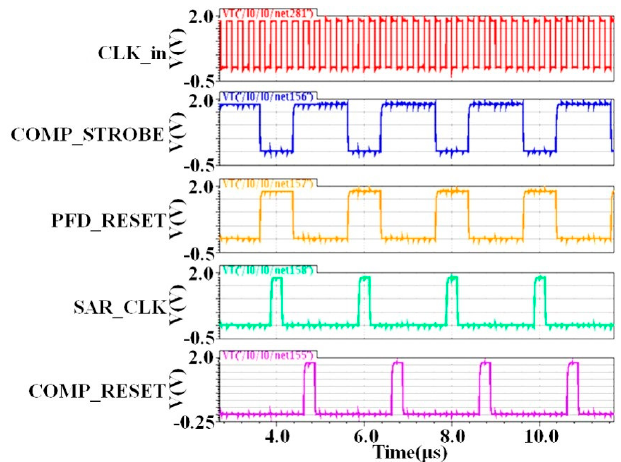
Figure 11. Simulation of the timing control.